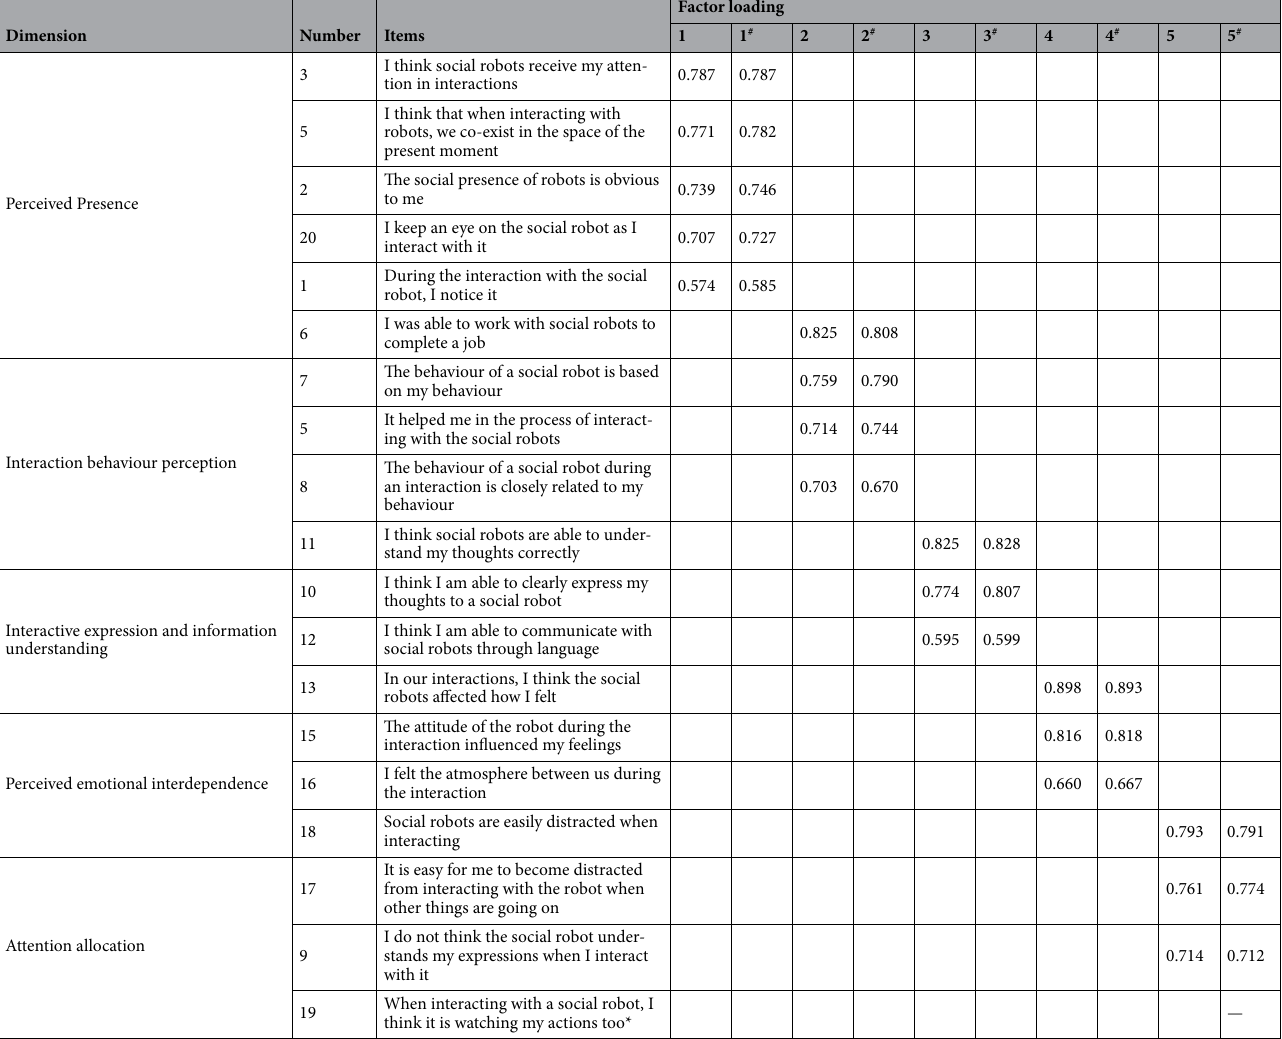
Table 5. Construction validity analysis of the pilot questionnaire survey. *indicates the item that was deleted due to action factor loading less than 0.5 in the first exploratory factor analysis. # indicates the results of the exploratory factor analysis after removing the